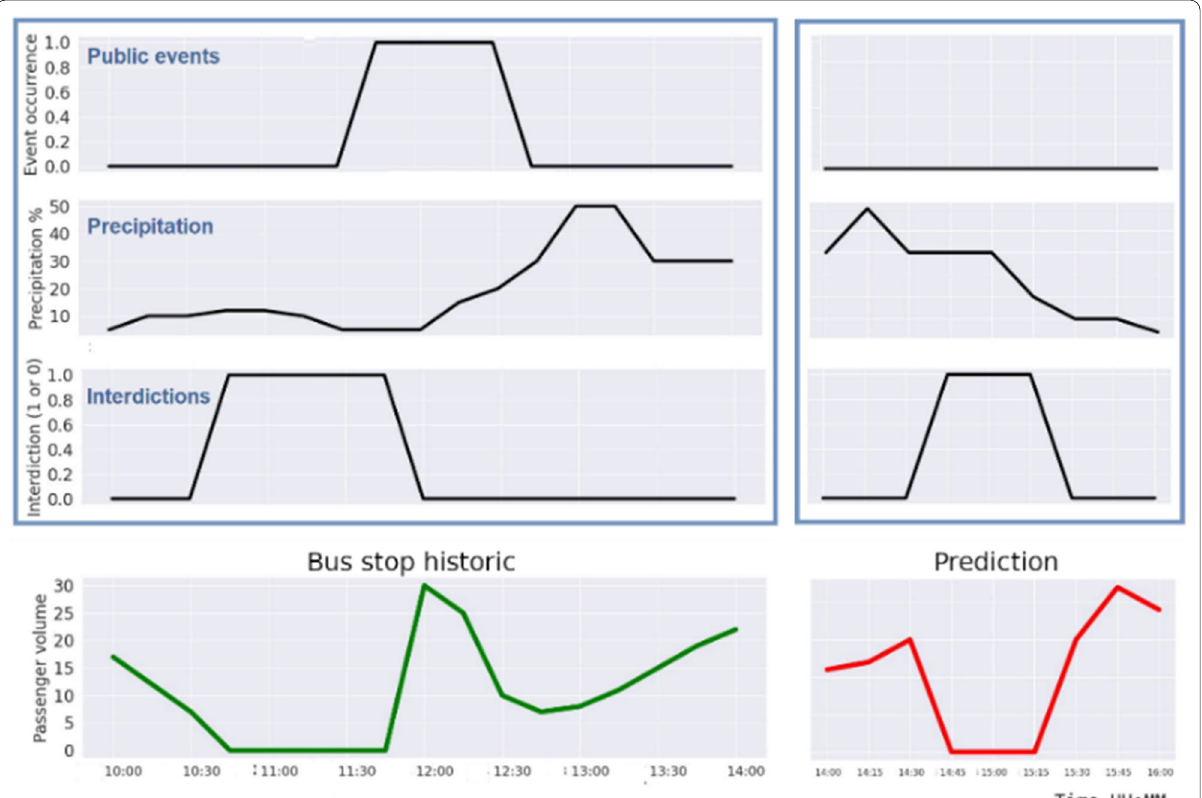
Fig. 5 Context masks: increasing the multivariate order of the target traffic time series data with context variables, including calendrical, meteorological and spatial variables